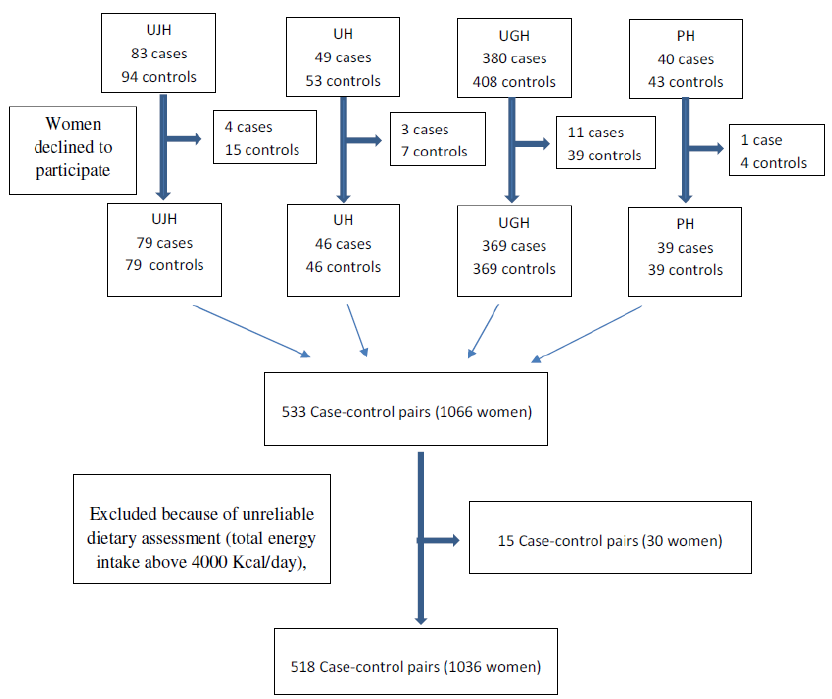
Figure 1. Participant flowchart. Abbreviation: The University of Jaén Hospital (UJH), Ubeda Hospital (UH), the University of Granada Hospitals (two centers) (UGH), and Poniente Hospital (PH).